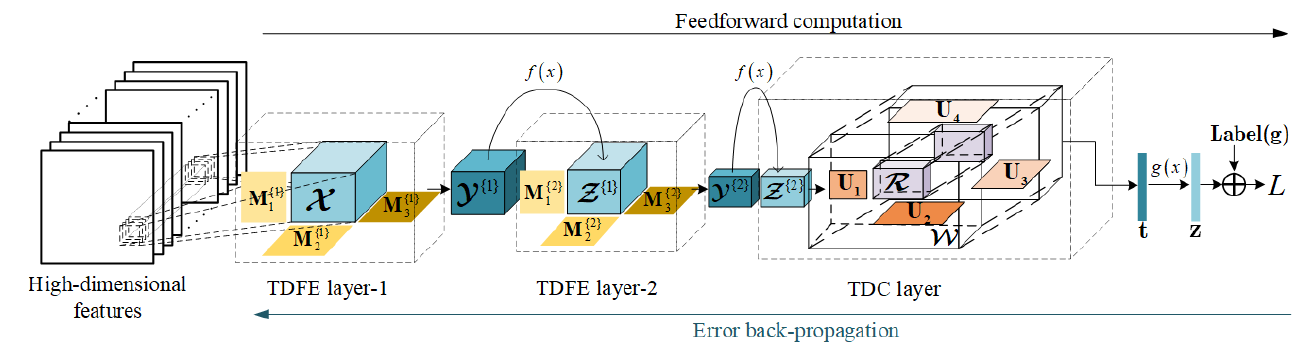
Figure 3. The architecture of the proposed